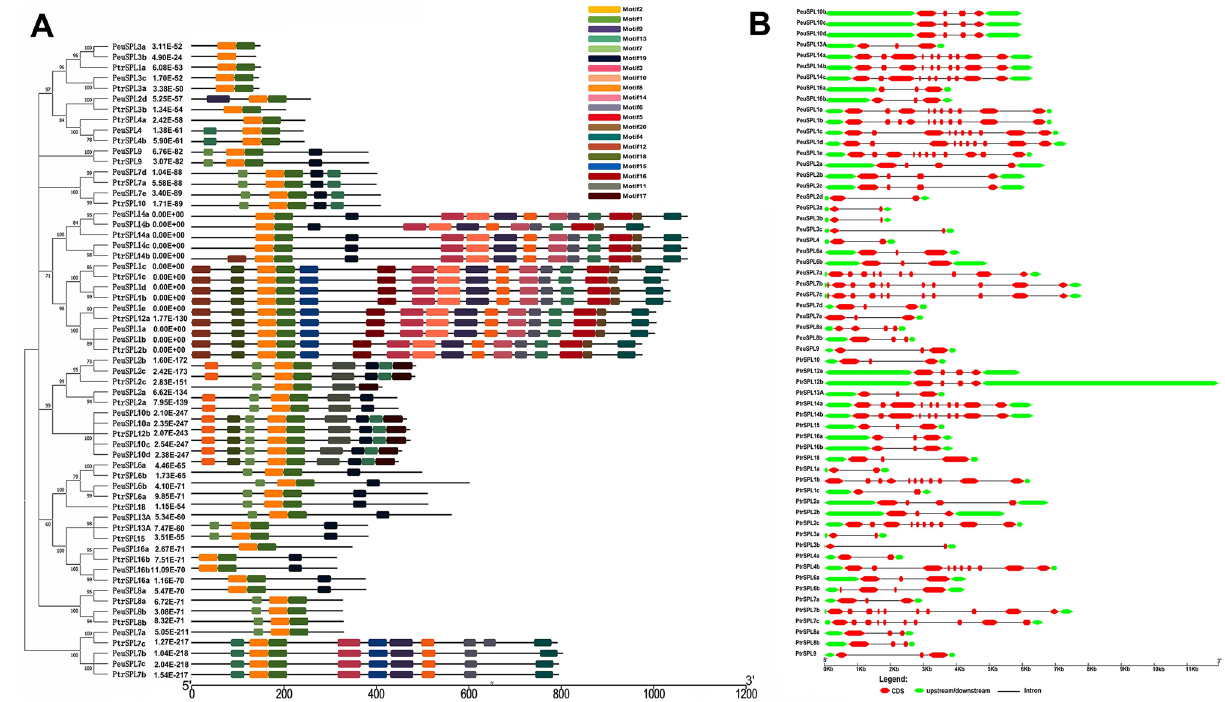
Figure 2. Genomic structure and motif composition of SPL proteins. ( A ) Motif analysis of SPL proteins from P. euphratica and P. trichocarpa . and conserved motifs in the SPL proteins are represented by colored boxes. The phylogenetic tree was constructed by MEGA 7 (https:// www. megas oftwa re. net/), motifs in the SPL proteins were elucidated by MEME 5.0.1(http:// meme- suite. org/), ( B ) Genomic structure of poplar SPL genes. Exons, introns, and UTRs are shown with red boxes, green boxes and black lines, respectively. Genomic structure was constructed by TBtools (https:// www. tbtoo ls.